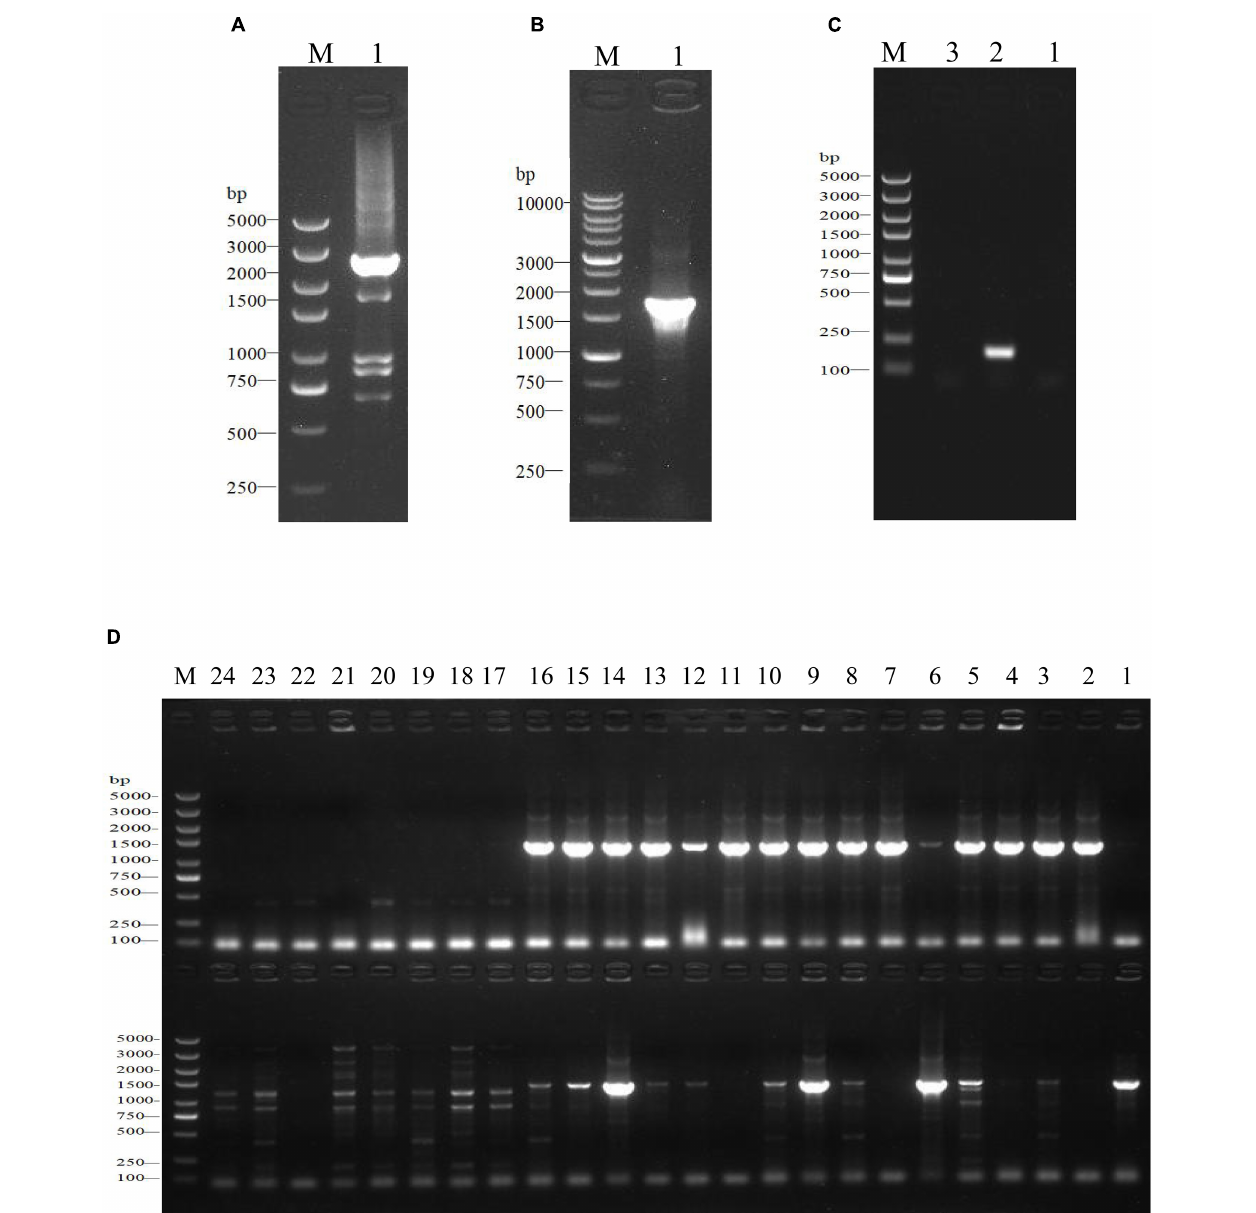
FIGURE 1 | Construction and identification of the SdiA deletion mutant of C. sakazakii by gel electrophoresis. (A) Construction of SdiA gene target shooting fragment. M: DL5000 DNA marker; 1: SdiA gene target shooting fragment (cid:49) sdiA :Cm (2650 bp). (B,C) Chloramphenicol resistance gene removal. (B) M: DL10000 DNA Marker; 1: Results of identification of lateral primers for colonies growing on non-resistant a TSA plates. (C) M: DL5000 DNA marker; 1: Identification results of lateral primers for colonies growing on non-resistant a LB plates; 2: Internal primer amplification results of the original strain (193 bp); 3: No template negative control amplification results. (D) Screening of SdiA gene knockout strain. M: DL5000 DNA marker; 1–24: Amplification results of primer pairs on both sides of 24 single colonies (Amplification results on both sides of 5 (cid:48) endpoints above; Amplification results on both sides of the 3 (cid:48) endpoint are shown